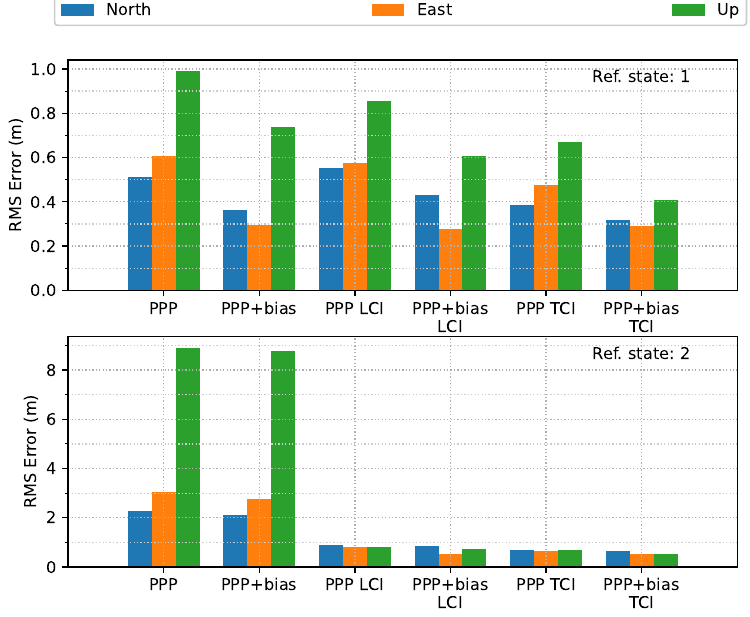
Figure 21. Error RMS of real-time GPS/Galileo PPP/INS results of road bridge test on 11 February